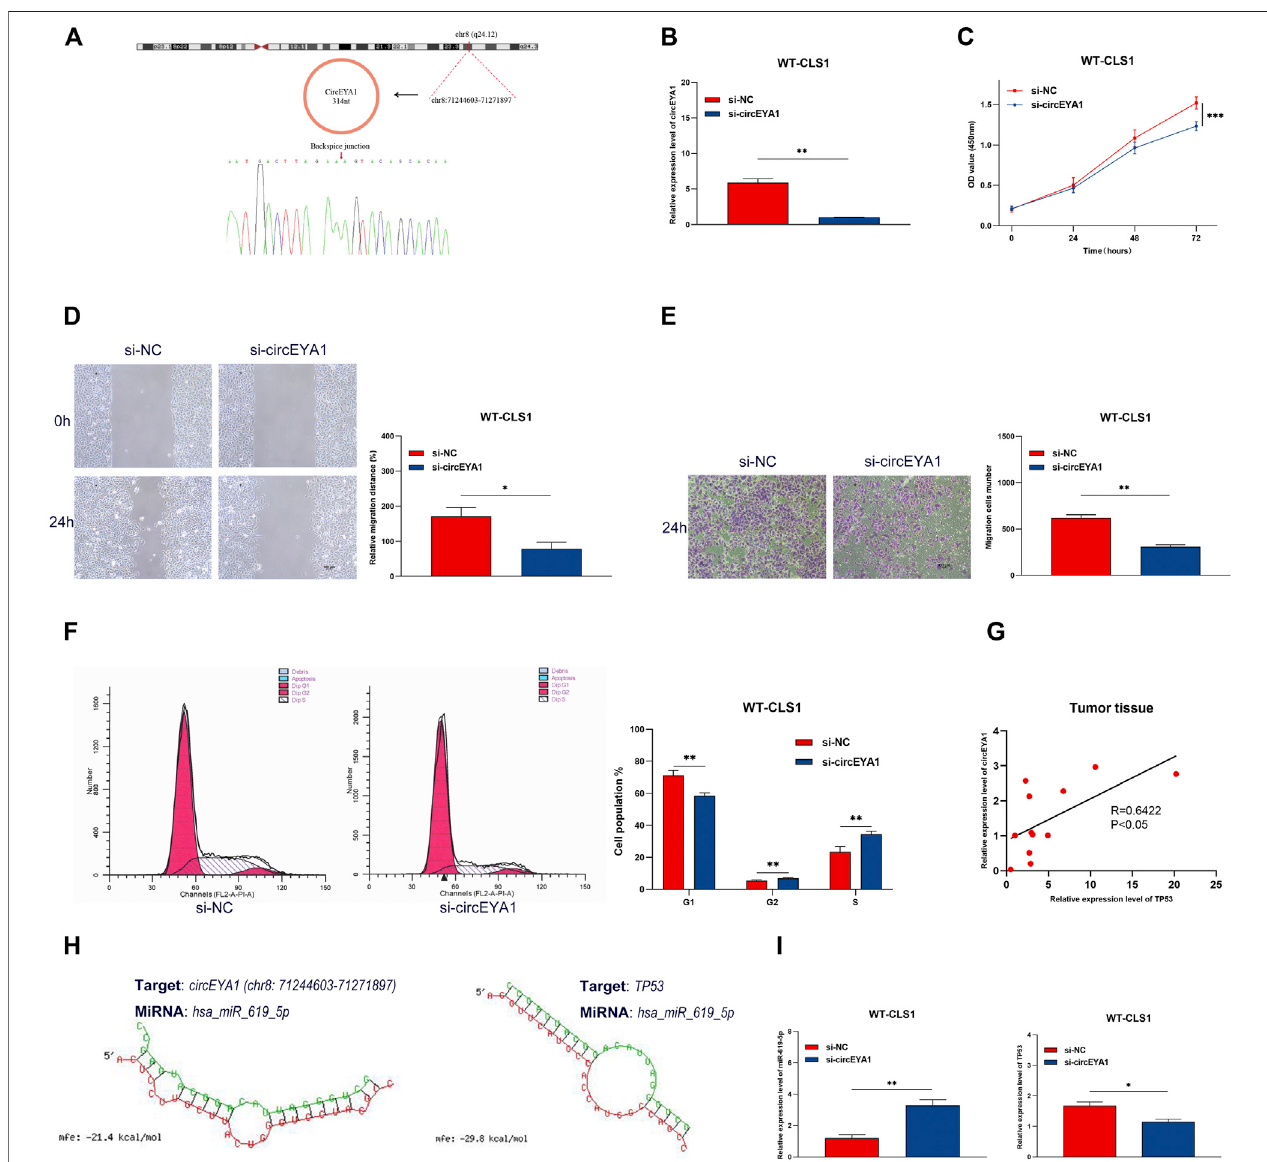
FIGURE 11 | Silencing of circEYA1 suppressed proliferation, invasion, and migration in WT cells. (A) The backsplice junction site of circEYA1 was identi fi ed by Sanger sequencing. (B) qRT-PCR analysis of circEYA1 expression in WT-CLS1 cells after transfection with siRNA targeting the back-splice site. (C) The proliferation of WT-CLS1 cells bythe CCK-8assay. (D – E) The migration and invasion ofWT-CLS1 cells bywound healingassaysand transwell assays. (F) circEYA1 silencing induced cellcyclearrestattheSandG2phases. (G) TherelativeexpressionofTP53mRNAhadapositivecorrelation withcircEYA1inWTtissuebyRT-qPCR. (H) Possible binding sites between miR-619-5p and circEYA1 or TP53. (I) Changes in relative expression levels of miR-619-5p or TP53 after circEYA1 silencing in WT-CLS1 cells. *: p < 0.05, **: p < 0.01, ***: p < 0.001.